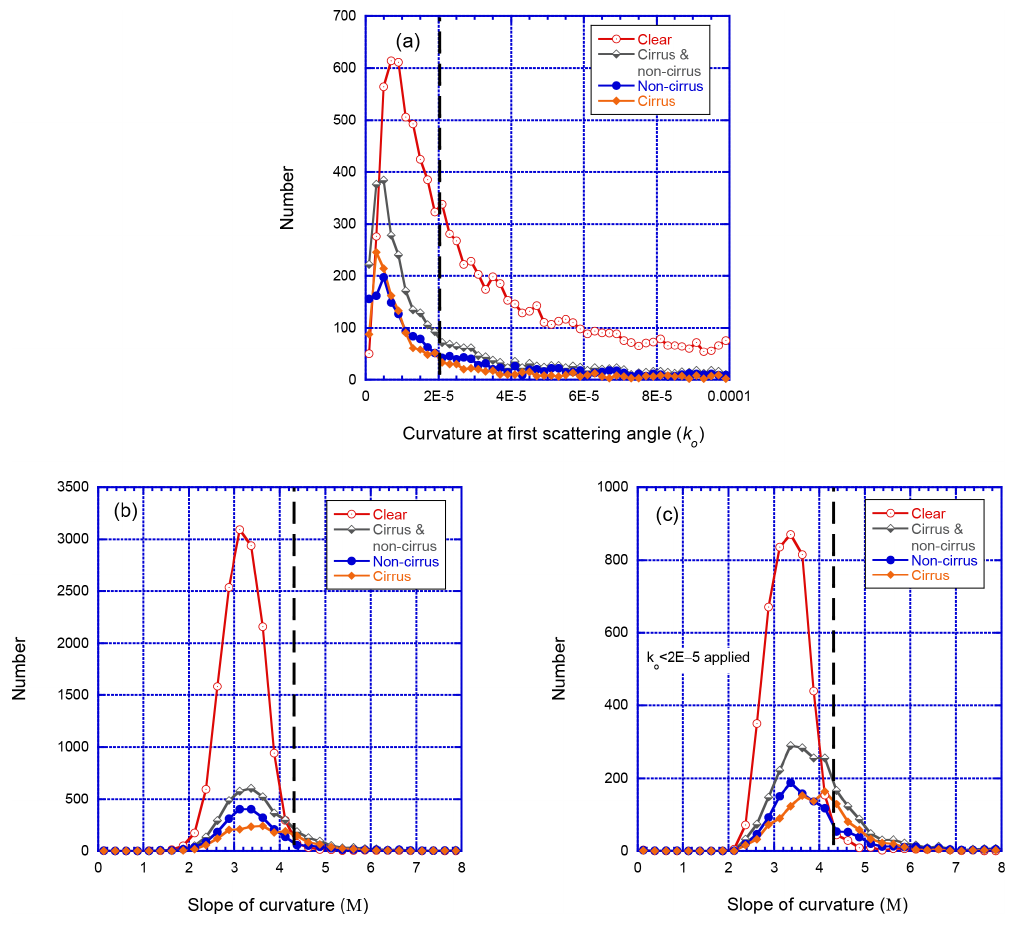
Figure 6. Similar to Fig. 4, except for Sede Boker (lat 30.85, long 34.78) from 2007 to 2013.